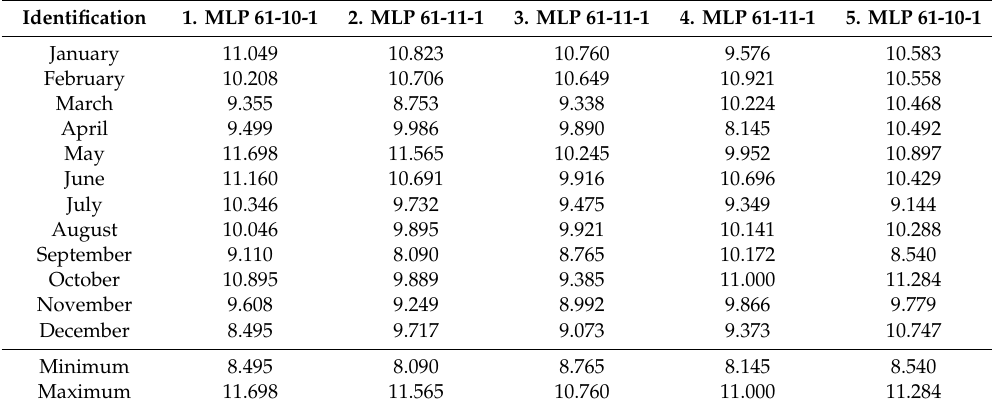
Table 10. Equalized time series residuals—months in a year.